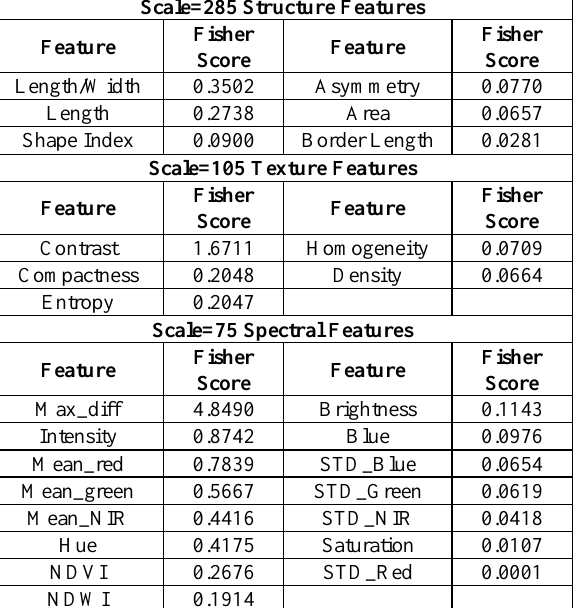
Table 2 Fisher Scores of Multi-scale Features